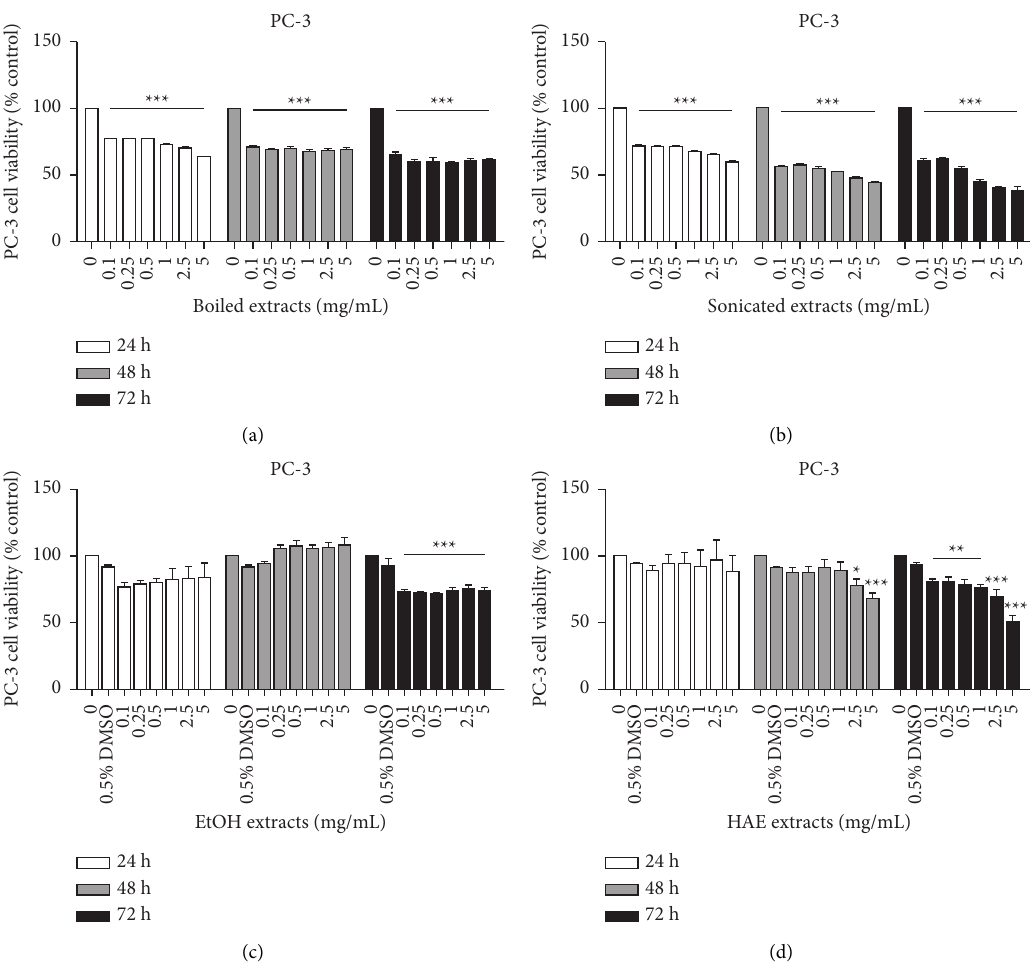
Figure 1: Te antiproliferative efect of crude aril extracts in PC-3 cells. Cells were cultured in 96-well plates and treated with various concentrations of diferent crude extracts (0–5mg/mL). (a) Boiled extract, (b) sonicated extract, (c) EtOH extract, and (d) HAE extract, and incubated for 24, 48, and 72h. Cell viability was determined by MTT assay. Data are presented as the means ± SEM ( n � 3) ( p < 0 . 05 ∗ , p < 0 . 01 ∗∗ , and p < 0 . 001 ∗∗∗ were considered signifcant compared to control) of three independent